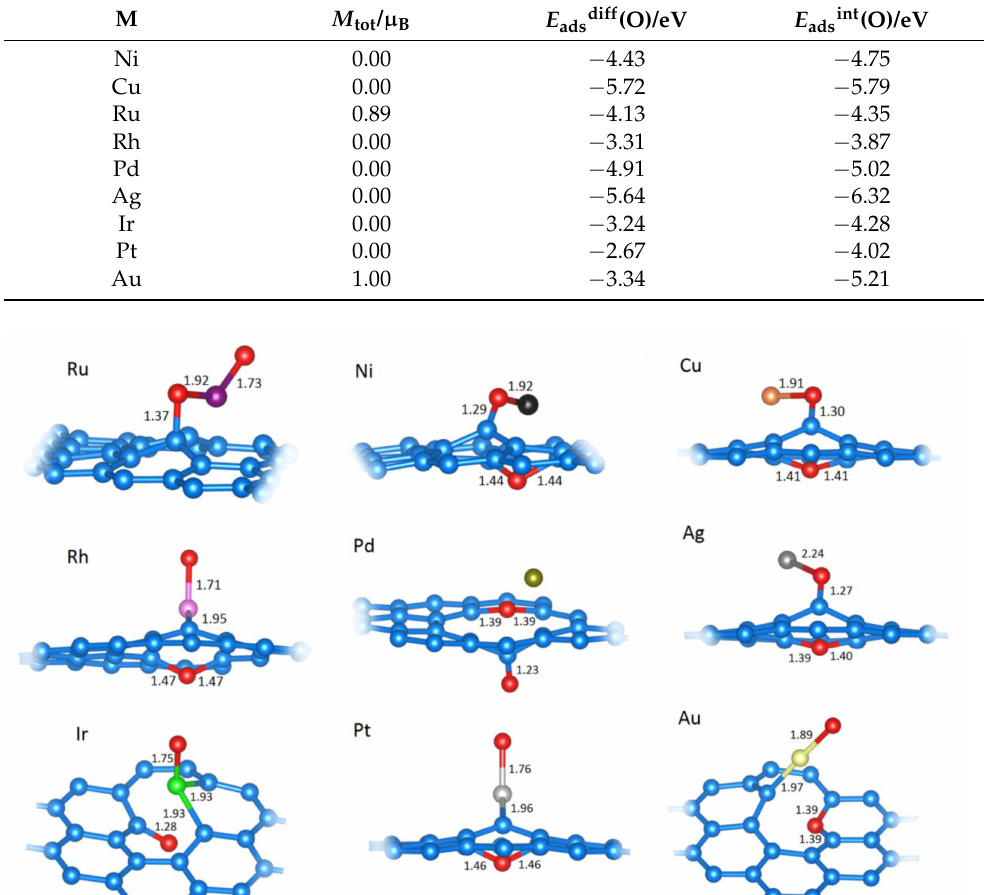
Table 5. Second O adsorption on the most stable site of M@vG: total magnetizations ( M tot ), O adsorption energies: differential ( E adsdiff (O)) and integral ( E adsint (O)).